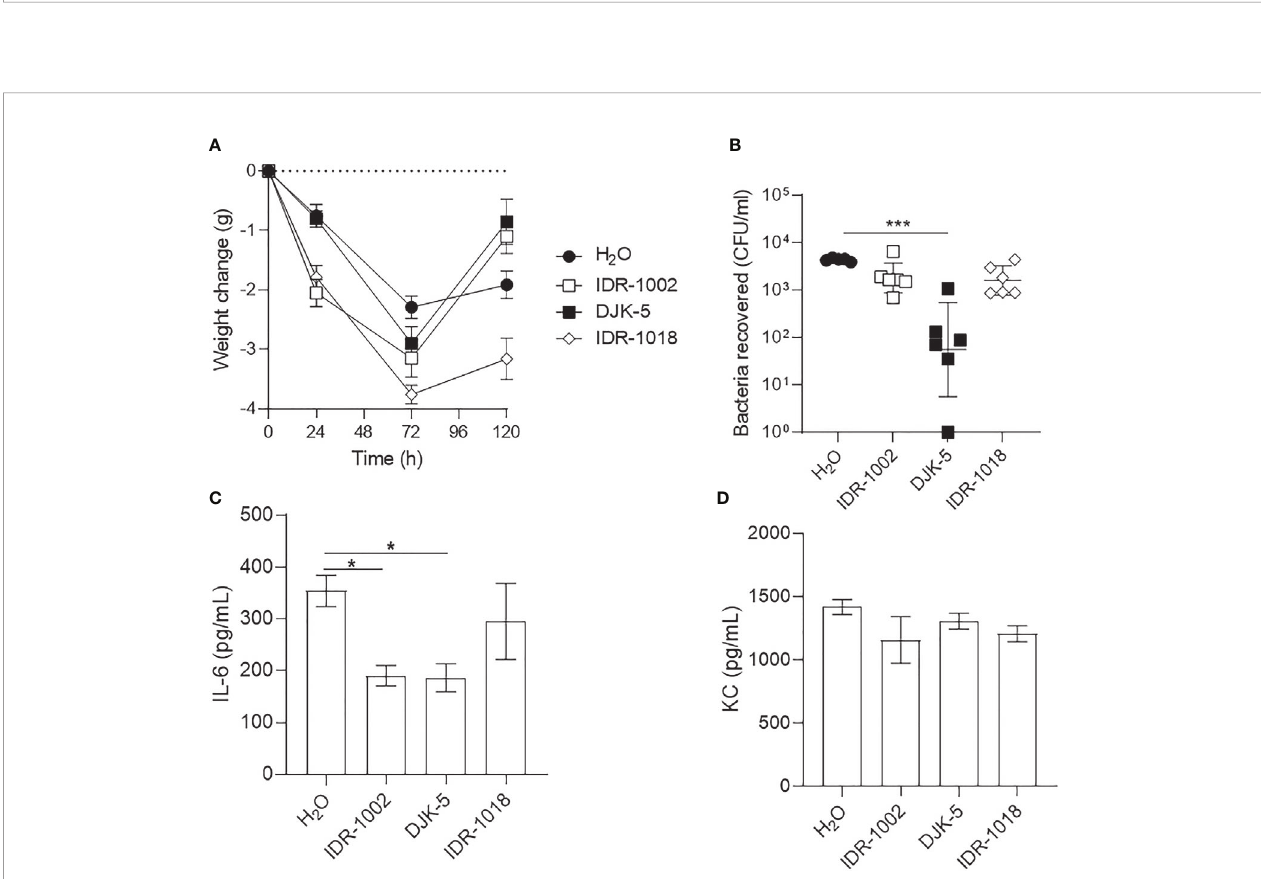
FIGURE 7 | Host-defense peptides exhibited immunomodulatory and/or antimicrobial activities during LESB65 infected mice. P. aeruginosa LESB65-Lux encapsulated in alginate were inoculated dropwise in the left naris of C57Bl/6 mice (~10 6 CFU). Mice were treated with endotoxin-free H 2 O (vehicle) or peptide (1.25 mg/kg) using a Respimat device 24-h post-infection. (A) Weight was recorded at 0-, 24-, 72-, and 120- h post-infection, and mean weight change from day 0 are reported. Lung homogenates were used to (B) enumerate bacterial burden and determine the production of (C) pro-in fl ammatory cytokine (IL-6) and (D) chemokine (KC/CXCL1). (A, B) Data are shown as geometric mean ± SD or (C, D) mean ± SEM. n ≥ 6. * P < 0.05, *** P < 0.001 according to Kruskal-Wallis test followed by Dunn ’ s correction.